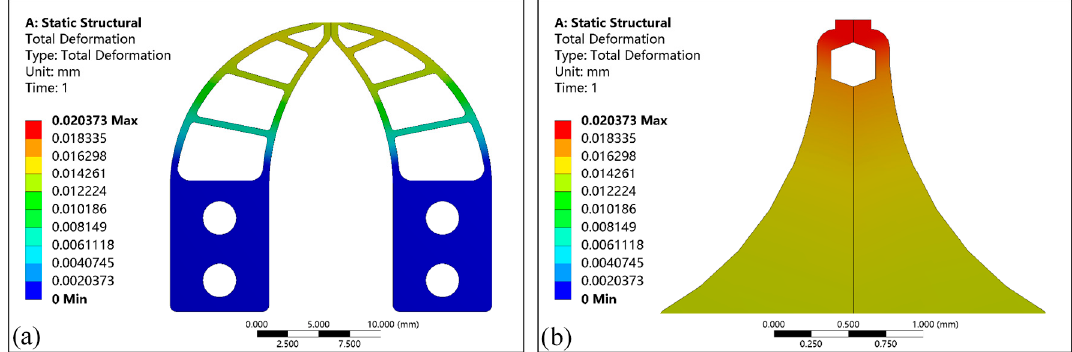
Figure 8. The simulation results of the deformation of the micro-gripper’s tip. ( a ) The deformation distribution in the assembly and in elastic-beam regions; ( b ) The deformation distribution in the tip-enveloped and tip-protected regions.